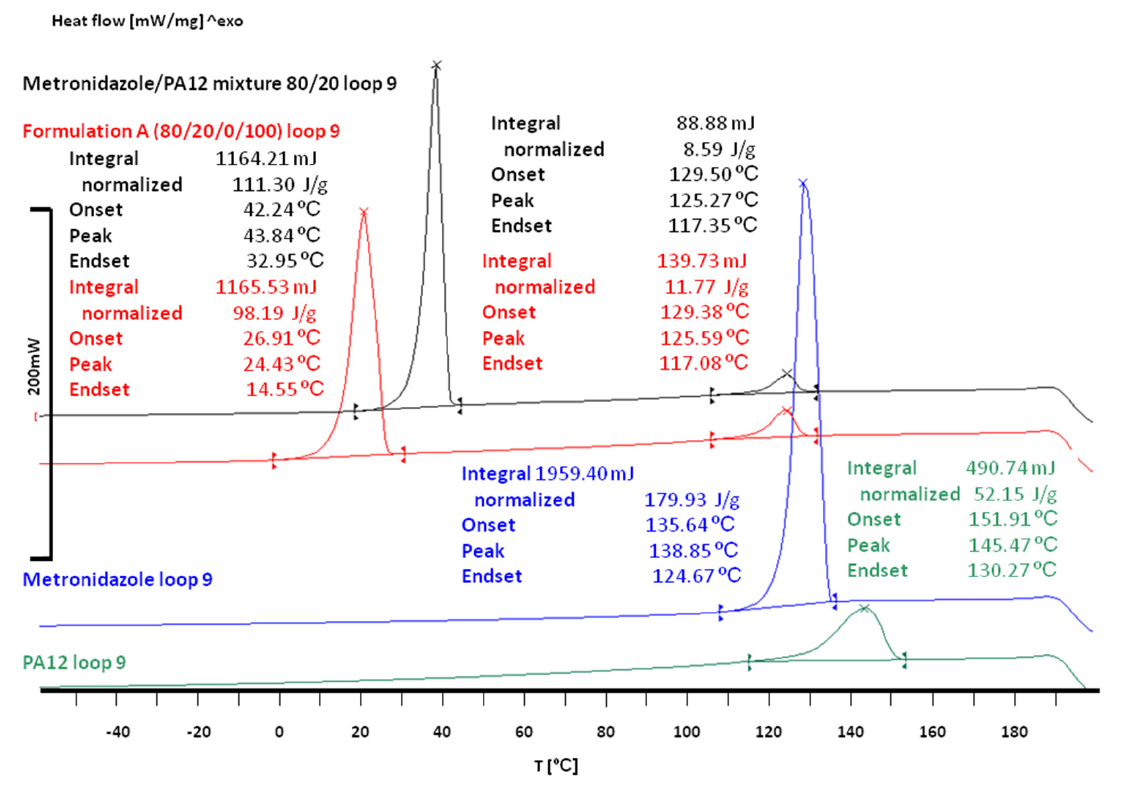
Figure 5. DSC curves from the thermal loop of Met (blue), PA12 (green), mixture (black) and Formulation A printlet (red); the 3rd segment-cooling from 200 °C to − 60 °C.